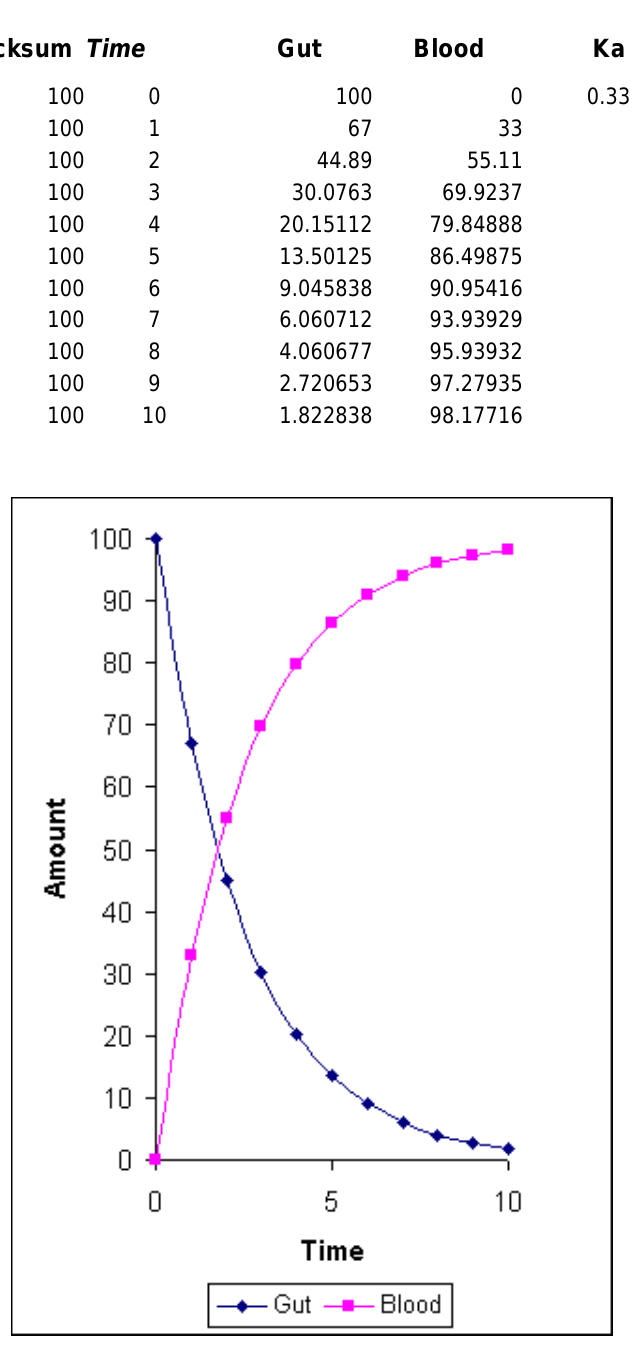
FIGURE 1 . Typical first-order decay from plot of values in Table